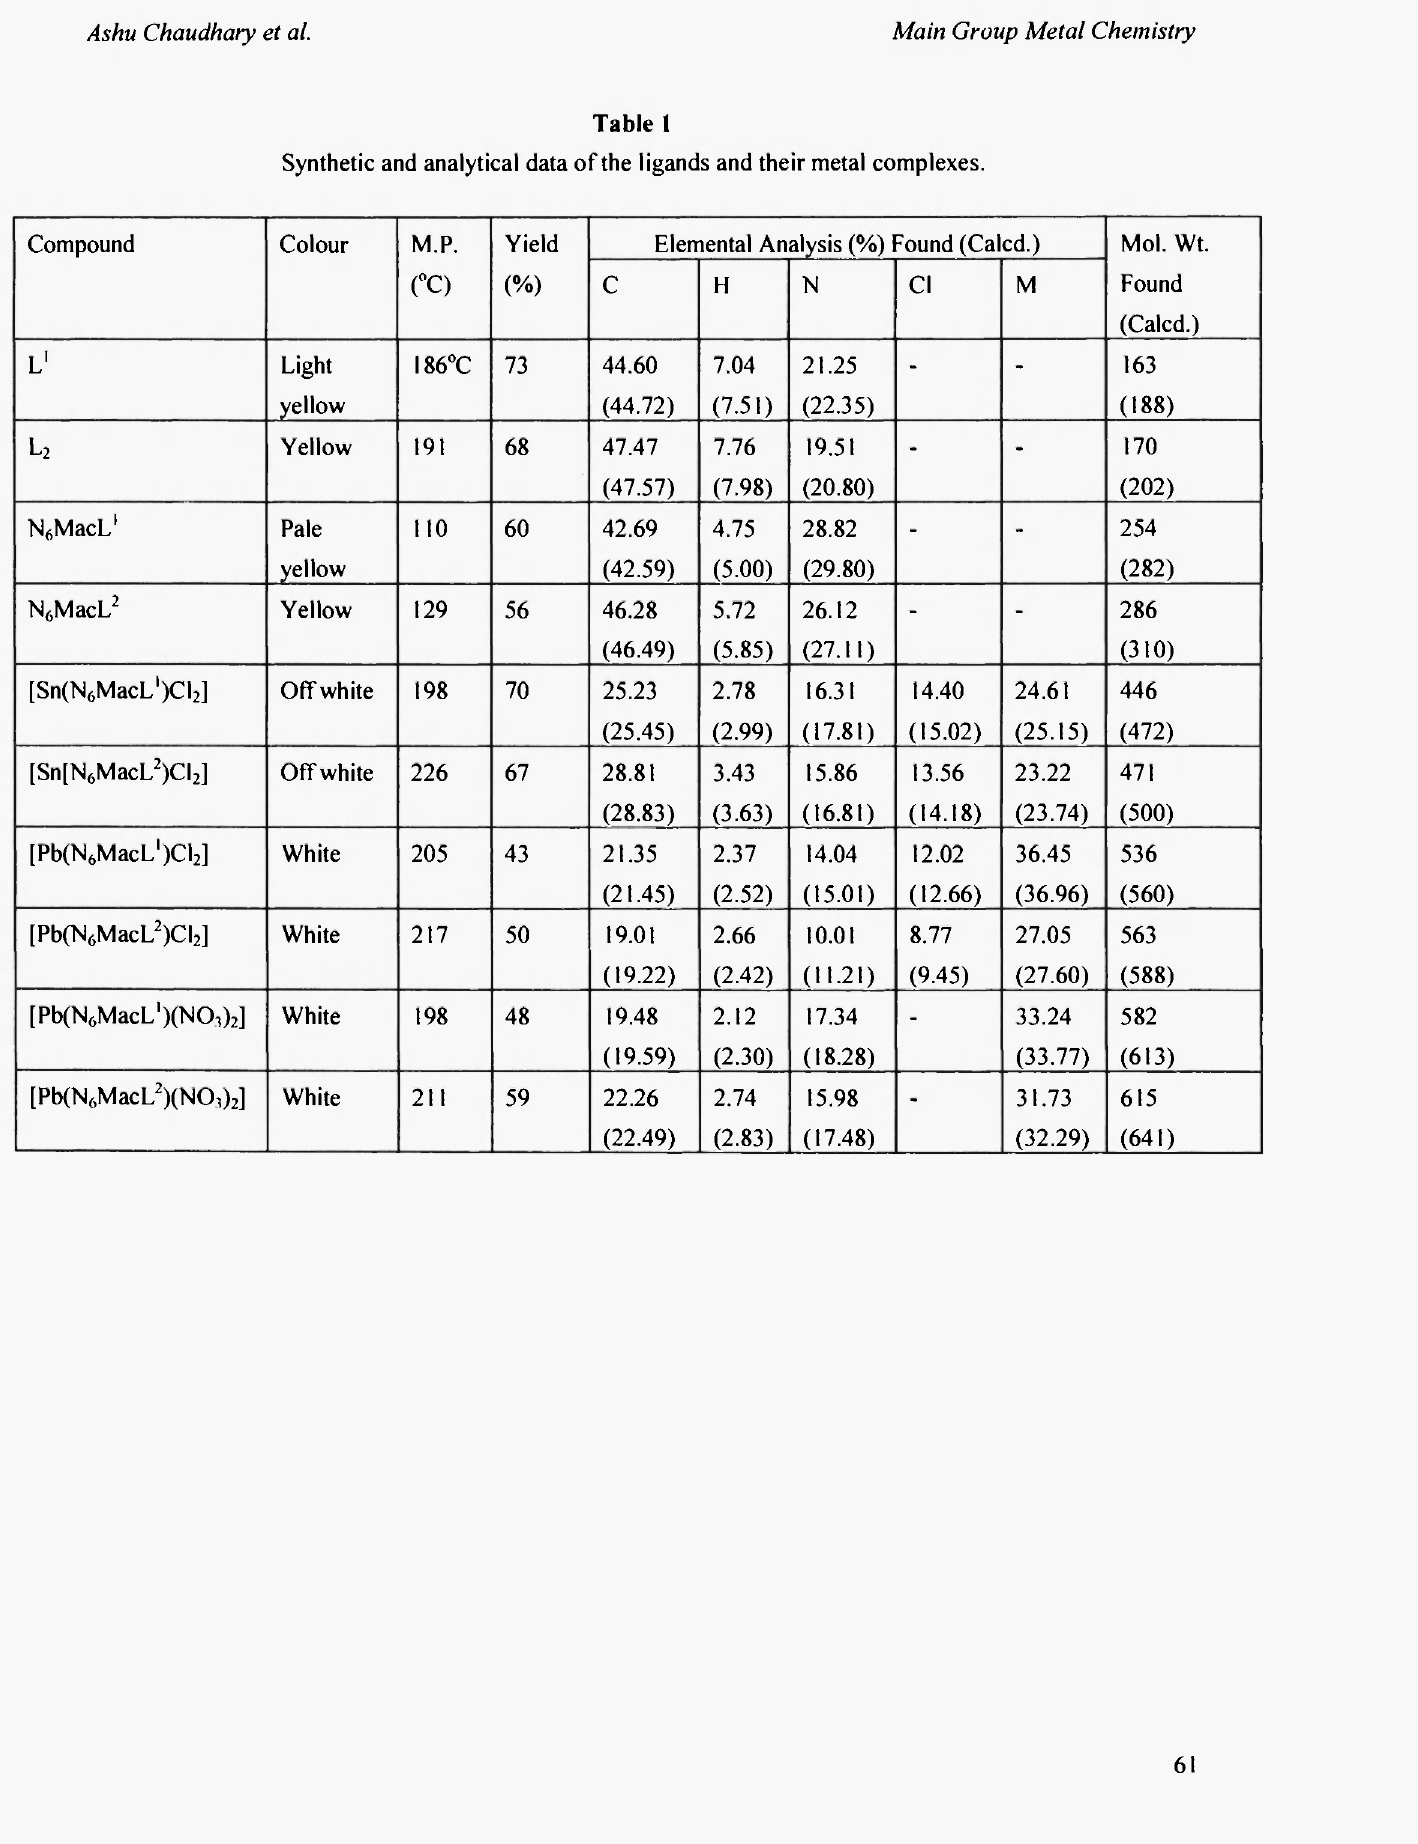
Synthetic and analytical data of the ligands and their metal